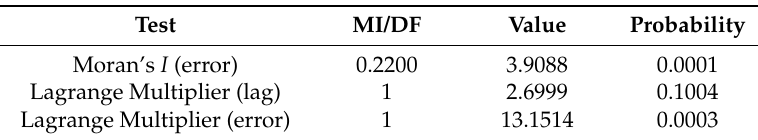
Table 5. Diagnostics for spatial dependence.